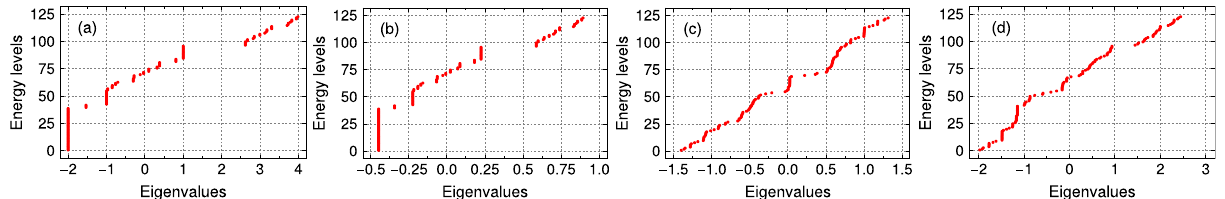
Figure 3. Eigenvalue spectra in the absence and presence of light with different irradiation parameters. ( a ) Absence of light, ( b ) A x